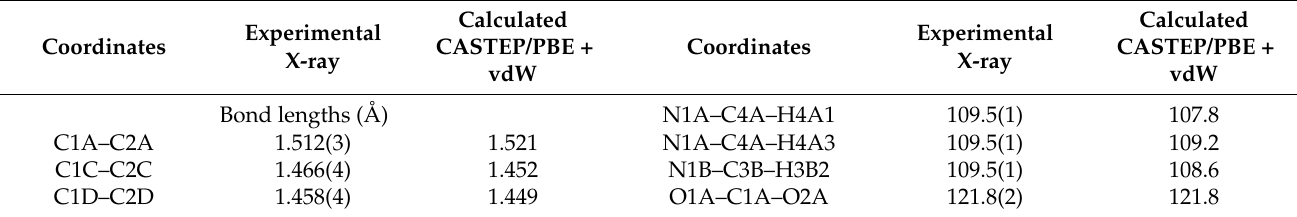
Table 2. Selected bond lengths, bond and torsion angles of N,N-dimethylglycine–chloranilic acid (DMG + –CLA − ) co-crystal at room